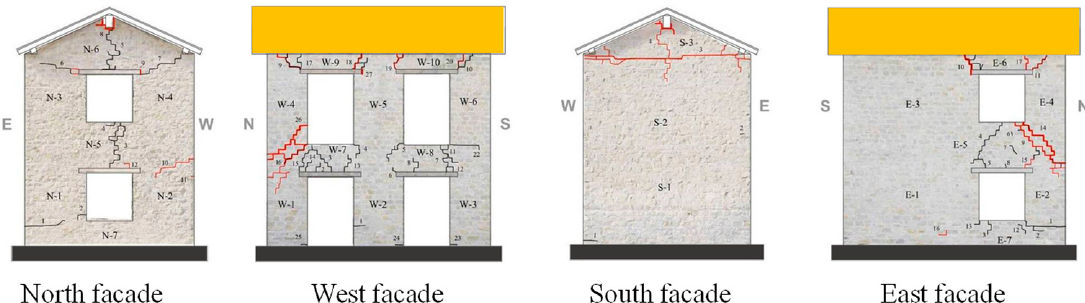
Figure 4. Crack pattern during test phase T 5 : in red, new cracks induced at PGA = 0.629 g and in black, the pre-existing ones.